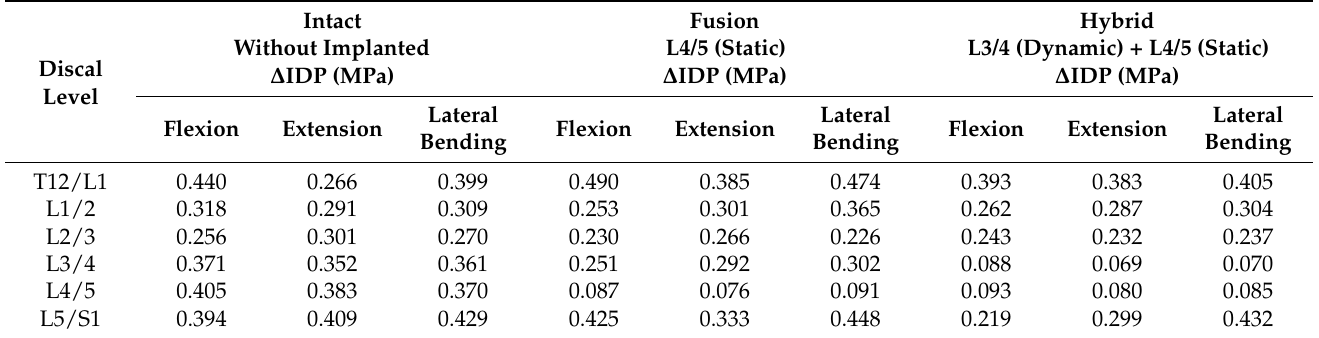
Table 1. Change in intradiscal pressure ( ∆ IDP) after 500 N follower load was applied for intact, static, and hybrid fixation constructs at flexion, extension, and lateral